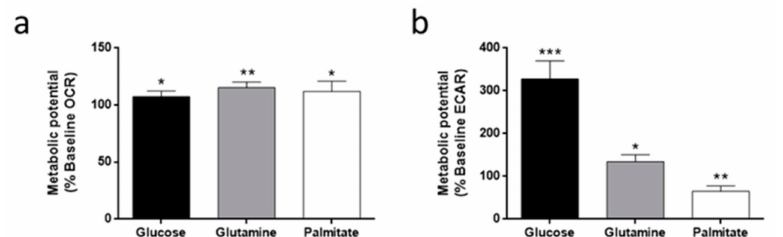
Figure 5. Flux analysis in HMEC. ( a ) Oxygen consumption rate (OCR) and ( b ) extracellular acidification rate (ECAR) in the presence of 5 mM glucose, 0.5 mM glutamine or 0.5 mM palmitate. Data are expressed as means ± SD of three independent experiments with triplicate samples each. * p < 0.05, ** p < 0.01, *** p < 0.001 versus control without any metabolic